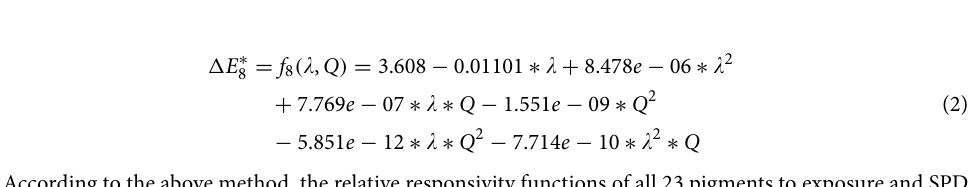
Figure 4. The three-dimensional variation surface of graphite’s color difference varying with SPD and